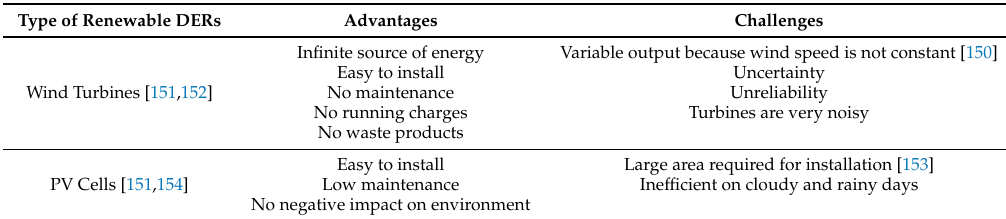
Table 9. Advantages and challenges of DERs